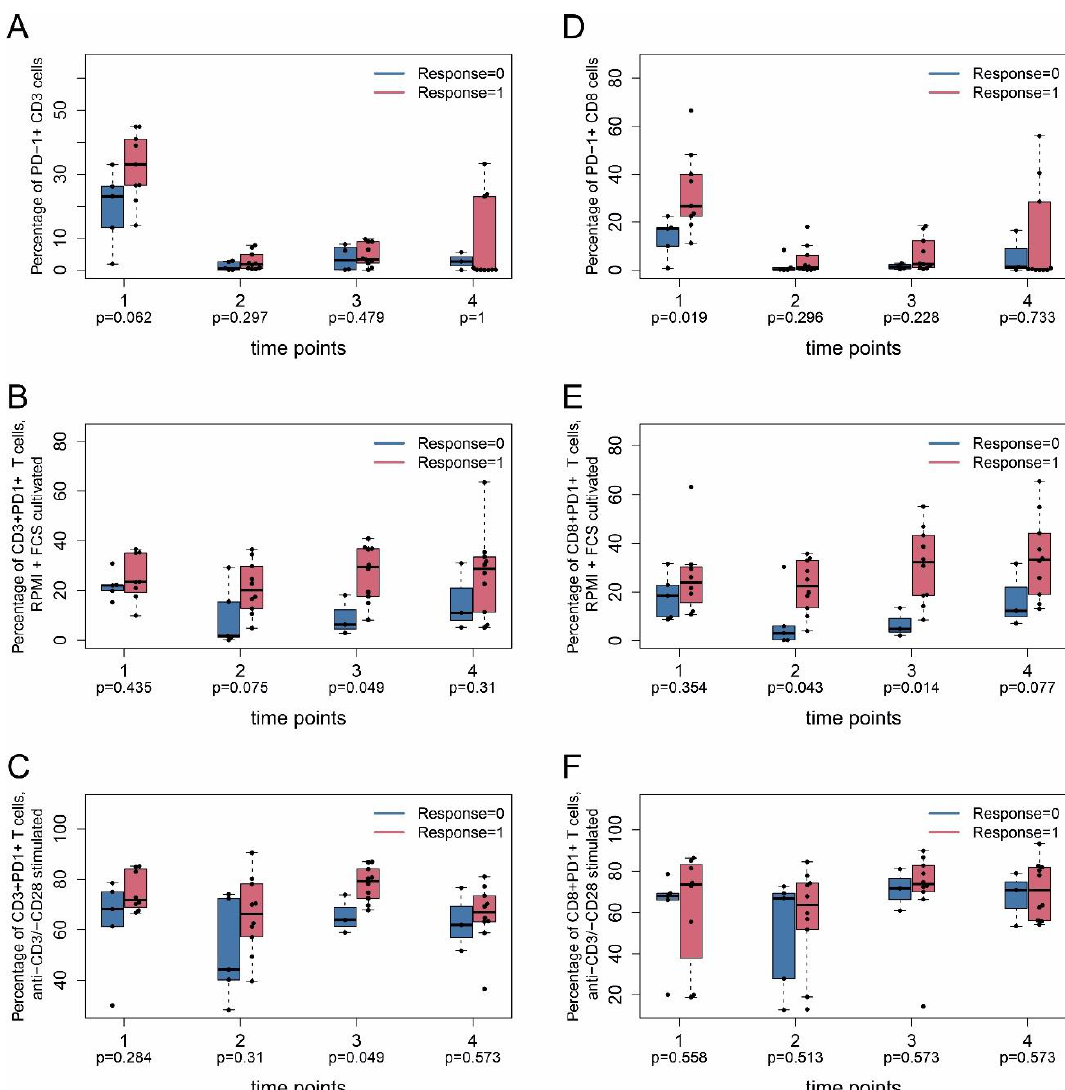
Figure 2. PD-1 expression on CD3 + and CD8 + T cells in ICI responders and non-responders. PBMC were taken from patients at indicated time points as described in Figure 1 and analyzed by flow cytometry (FACS). ( A , D ) PD1 + CD3 + or PD1 + CD8 + expression without stimulation. ( B , E ) PD1 + CD3 + or PD1 + CD8 + expression in control cells after cell culture in 10% FCS. ( C , F ) PD1 + CD3 + or PD1 + CD8 + expression after anti-CD3/anti-CD28 stimulation. Nominal (unadjusted) p -values (Mann–Whitney U test between responders and non-responders) are shown without adjustment for multiple testing. Responders are indicated by response = 1, non-responders by response = 0. Data in ( A )–( F ) are given as percentage of PD-1 + cells of total CD4 + and CD8 + T cells, respectively.